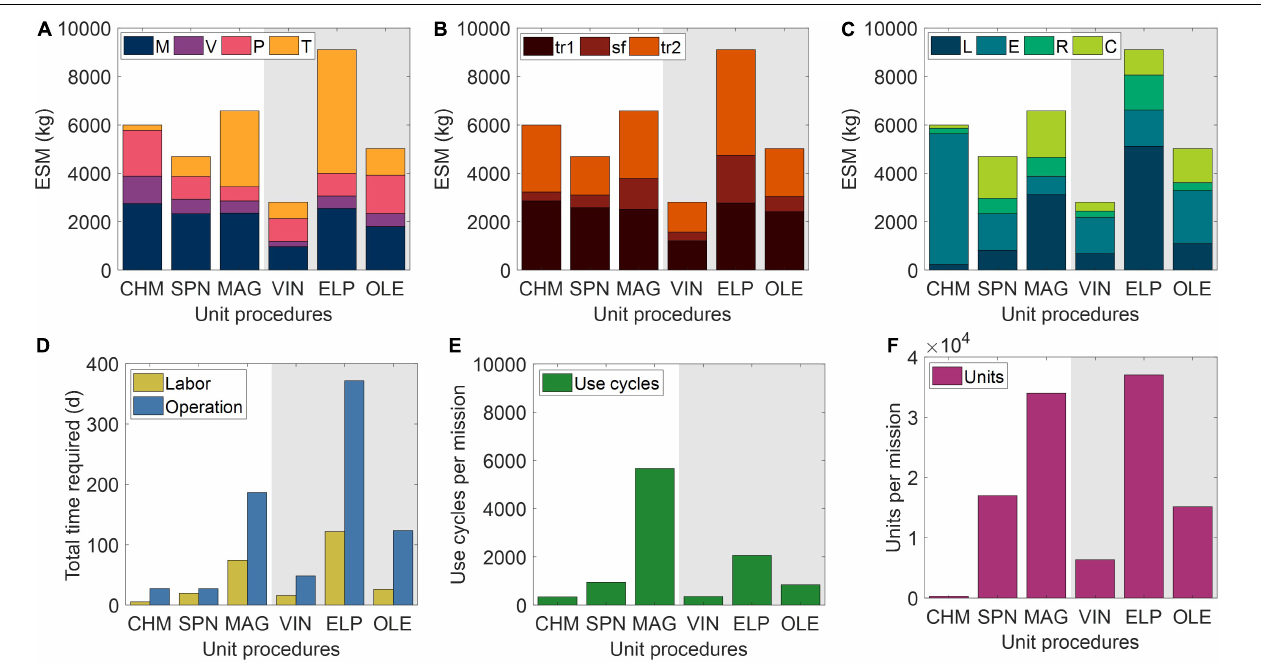
FIGURE 4 | Base case equivalent system mass results broken down by (A) mass (M), volume (V), power (P), and labor time (T) constituents, (B) transit to Mars (tr 1 ), surface operations (sf), and return transit (tr 2 ) mission segments, and (C) labor (L), equipment (E), raw materials (R), and consumables (C) cost category for the six tested Protein A-based monoclonal antibody affinity capture step unit procedures segregated by abiotic (white background) and biotic (gray background) technologies. Also shown are the (D) labor and operation times, (E) number of use cycles, and (F) number of units required for each unit procedure to meet the reference mission demand. CHM, pre-packed chromatography; SPN, spin column; MAG, magnetic bead; VIN, plant virus-based nanoparticle; ELP, elastin-like polypeptide; OLE,